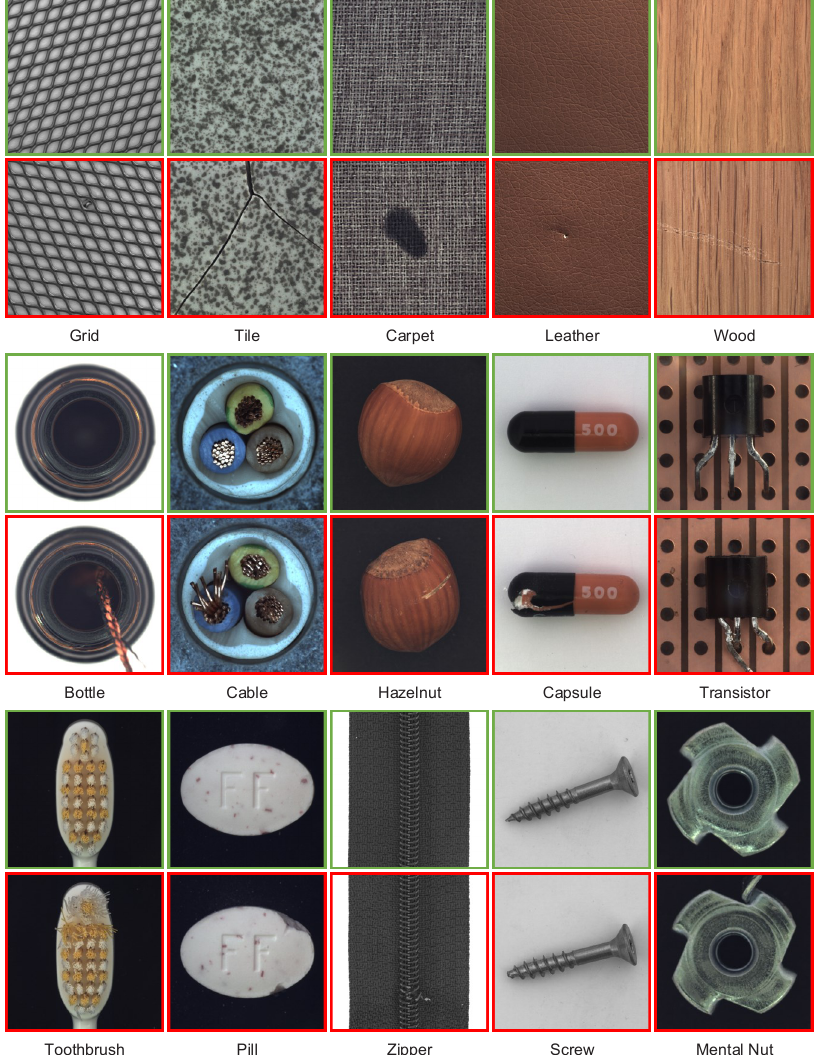
Figure 3. Examples of normal and abnormal images for each class on MVTec AD dataset. For each class, the top row shows normal image, and the bottom abnormal